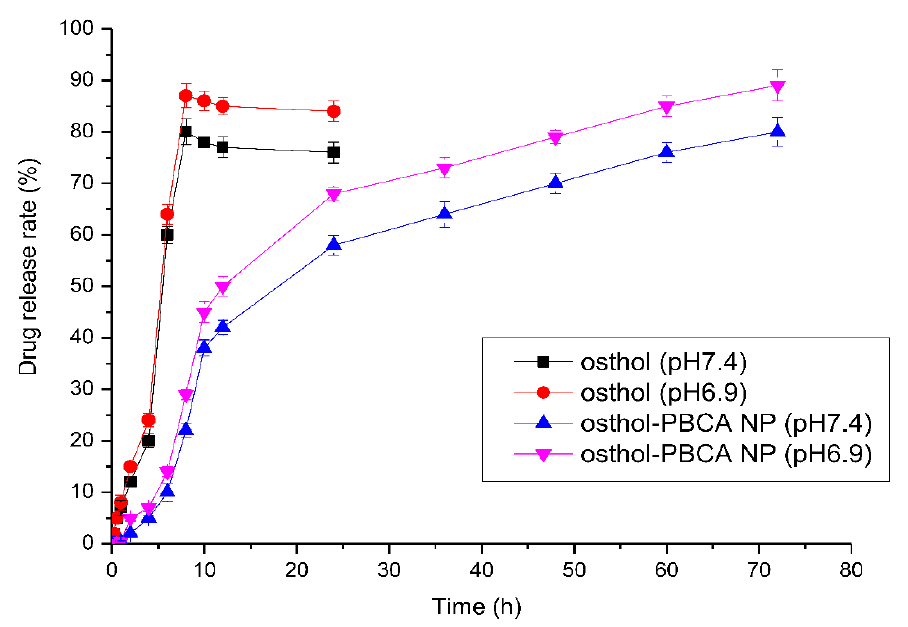
Figure 5. The drug release process of osthol and osthol-PBCA NPs in